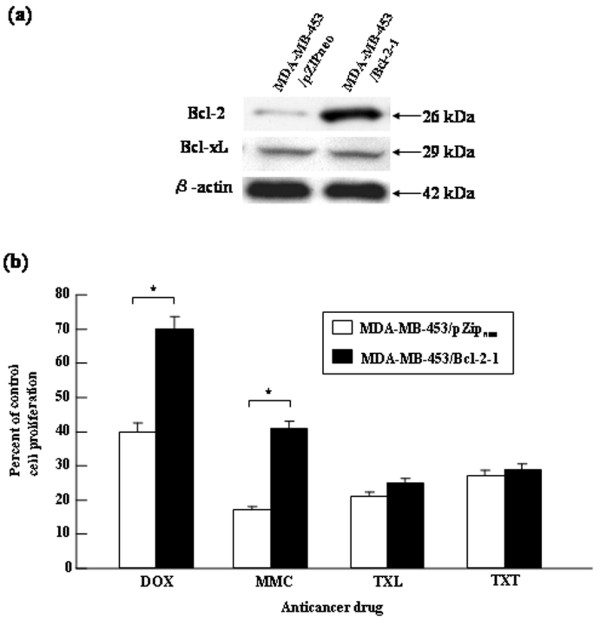
Changes in chemosensitivity of MDA-MB-453 cells to anticancer drugs after transfection with bcl-2 gene. (a) Expression levels of Bcl-2 and Bcl-xL were examined in MDA-MB-453 cells by Western blot analysis. MDA-MB-453 cells transfected with the bcl-2 gene expressed greater levels of Bcl-2 protein; however, similar levels of Bcl-xL protein were observed. (b) Cells treated with 0.15 μM doxorubicin (DOX) or with 2.0 μM mitomycin C (MMC), paclitaxel (TXL) or docetaxel (TXT). After 48 hours, cells were stained with trypan blue and counted. Each point represents the mean of triplicate experiments. Error bars indicate SD. *, P < 0.05, Student's t-test. The data presented are from three independent experiments.